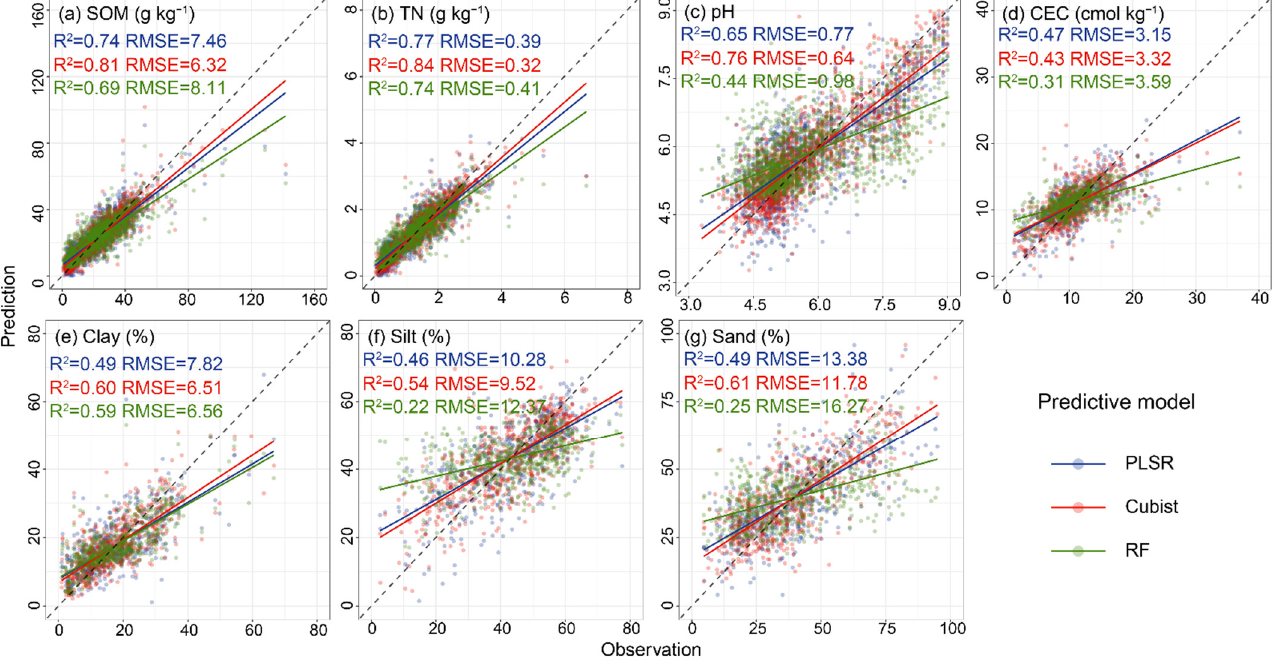
Figure 4. Scatter plots of observed versus predicted soil properties using three predictive algorithms. The three colors of lines, points and texts correspond to three predictive algorithms. The dashed black line is the 1:1 line.